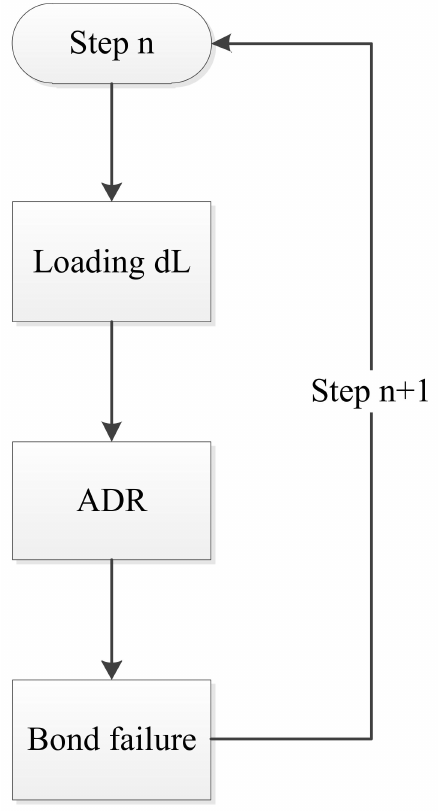
Figure 6. PD DCB modeling